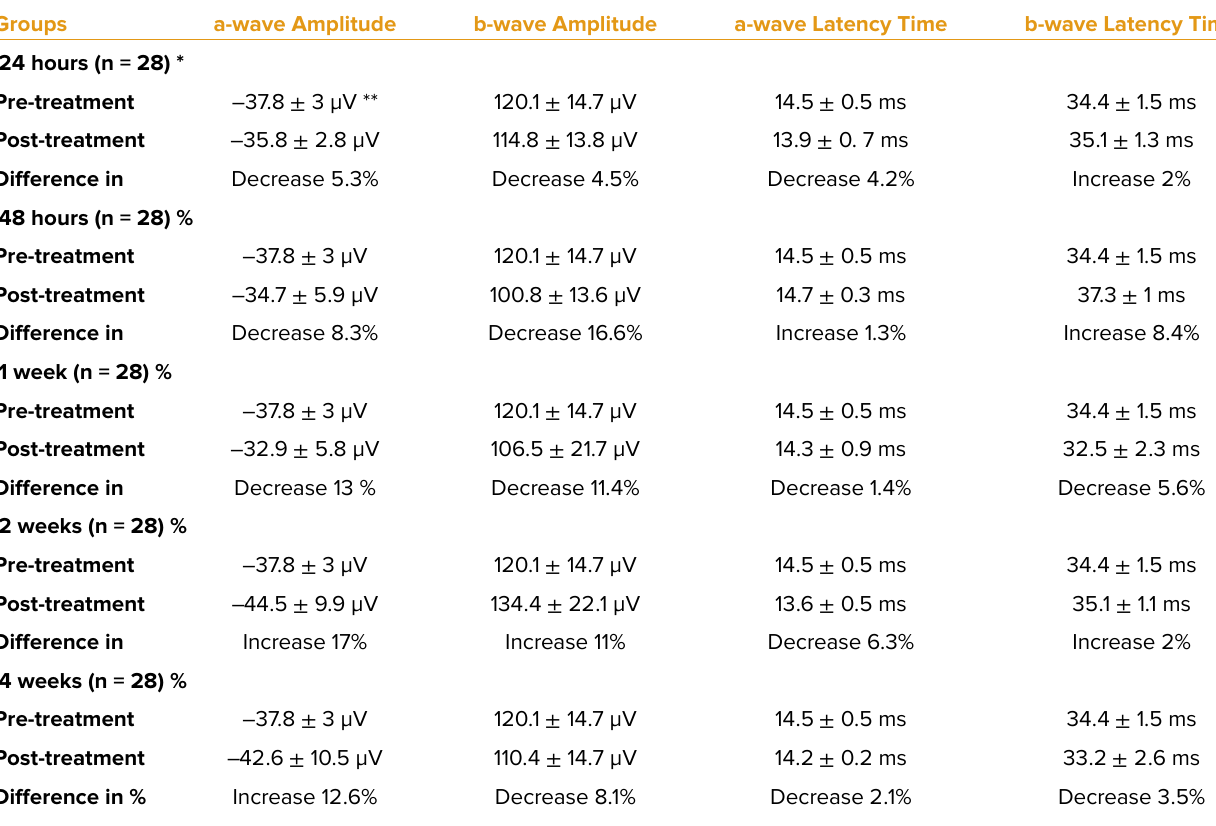
Table 3. The amplitudes and latency times of ERG waves from the Avastin-treated rabbits (28 eyes)